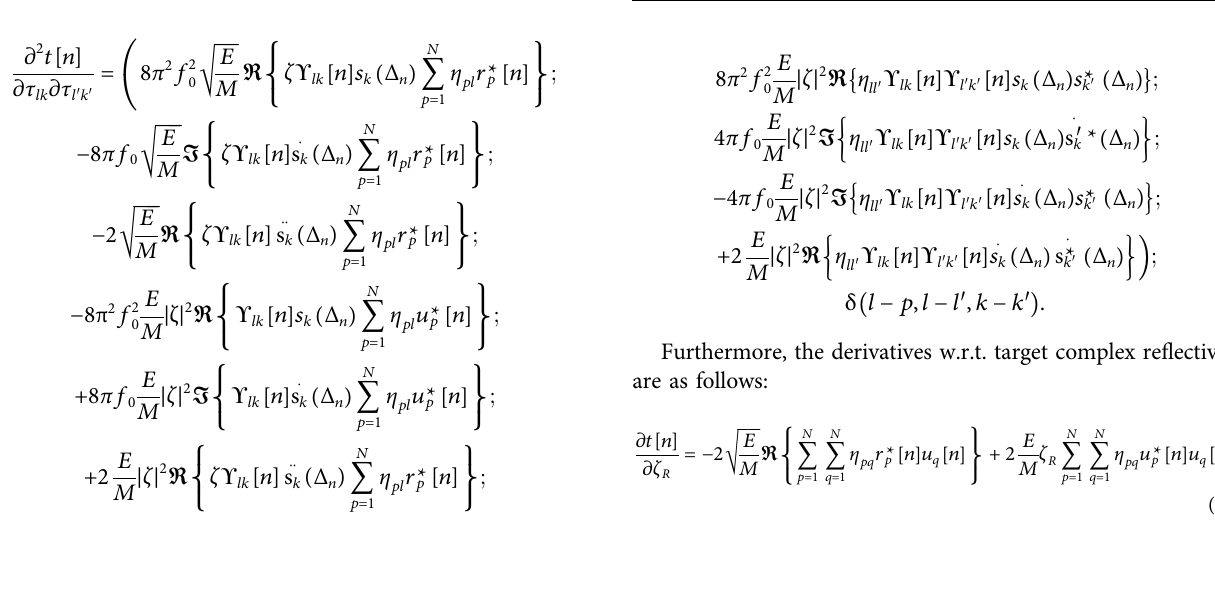
Frontiers in Signal Processing |